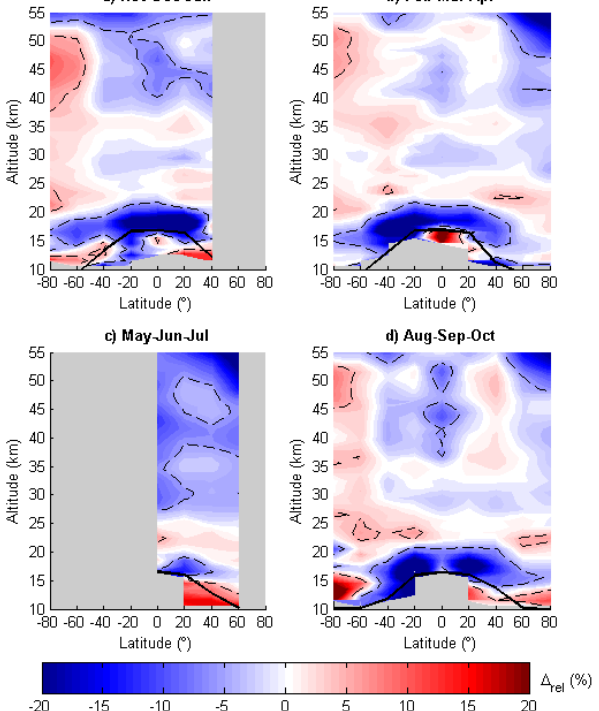
Fig. 7. As for Fig. 6a for 20 ◦ latitude bins in (a) November, Decem- Figure 7: As for Fig. 6a for 20° latitude bins in (a) November, December and January, (b) 4 ber and January, (b) February, March, and April, (c) May, June, and February, March, and April, (c) May, June, and July, and (d) August, September, and 5 July, and (d) August, September, and October. October. 6